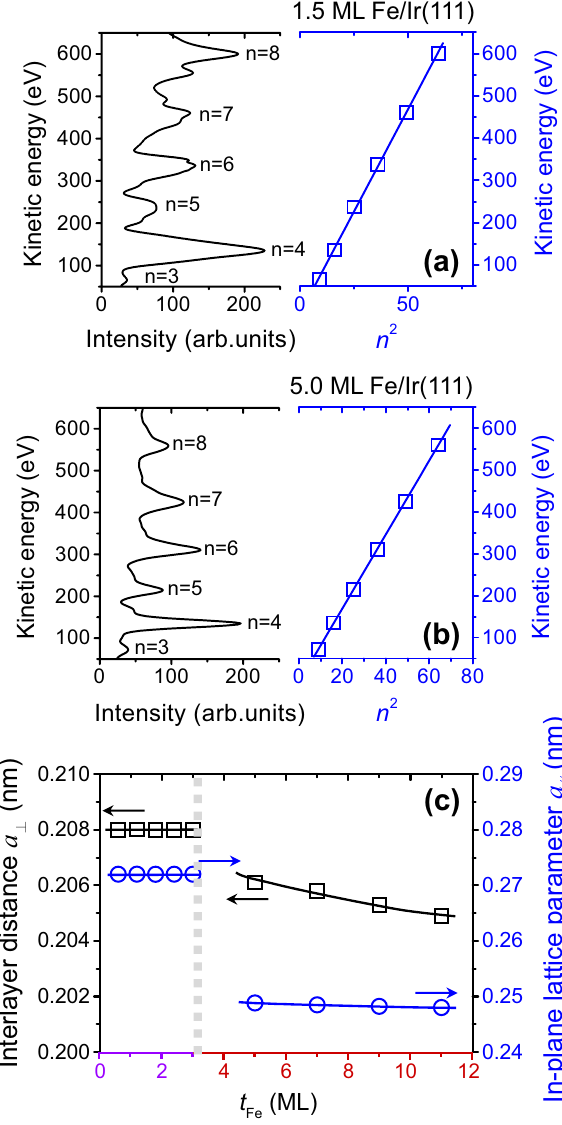
Figure 2. LEED I–V curves and E–n 2 plots of ( a ) 1.5 ML Fe/Ir(111) and ( b ) 5.0 ML Fe/Ir(111). ( c ) Interlayer distance a and in-plane lattice parameter a // versus Fe ⊥